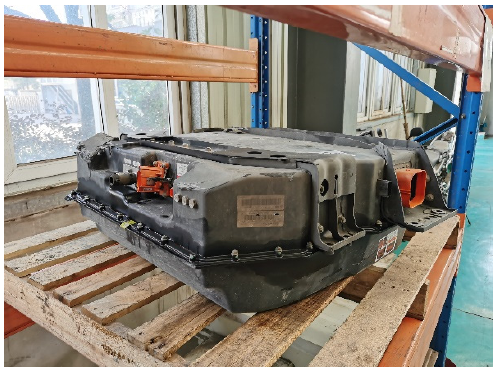
Figure 1. LiFePO 4 electric vehicle (EV) battery pack.